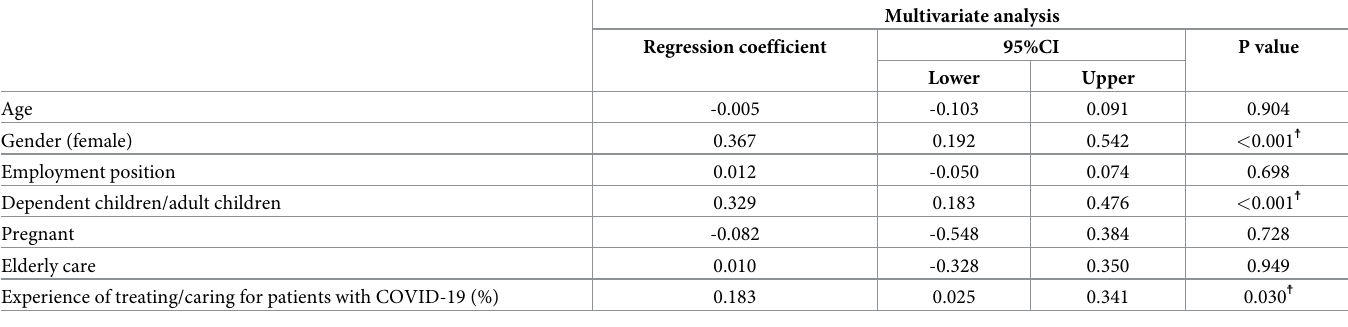
regression analysis, we investigated what factors were statistically related to an increased domestic burden during the first and second waves (Table 3). We found that gender (p < 0.001), having dependent children/adult children (p < 0.001), and the experience of treat- ing patients with COVID-19 (p = 0.03) were significantly and positively related to an increased domestic burden. Table 3. Factors related to the domestic burden for physicians during the COVID-19